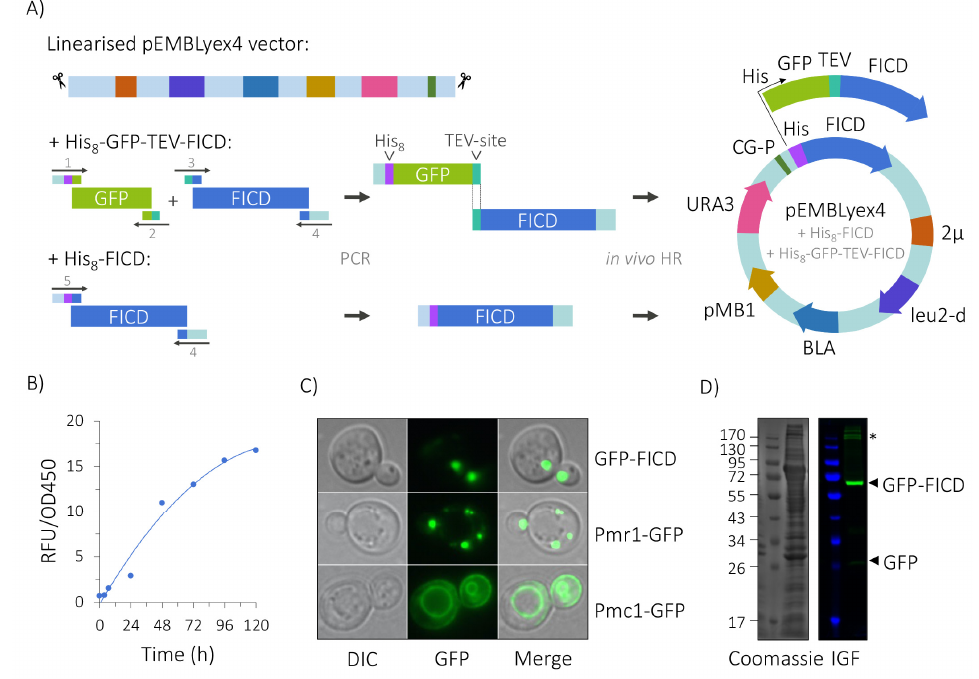
Figure 3. Generation and expression of FICD constructs. ( A ) FICD was tagged with His 8 -GFP-TEV (where TEV denotes a tobacco etch virus protease cleavage site) or His 8 alone and ligated into linearised pEMBLyex4 vector by in vivo homologous recombination (HR) in S. cerevisiae . The His 8 -GFP- TEV, TEV-FICD and His 8 -FICD DNA fragments were constructed by PCR using appropriate cDNA templates and primers containing overlapping sequences (see Table S1 for primer details). CG-P, CYC-GAL promoter; leu2-d , a poorly expressing allele of the β -isopropylmalate dehydrogenase gene; URA3 , selective marker gene encoding the orotidine-5 ′ -phosphate decarboxylase enzyme; BLA , β -lactamase gene; 2 μ , 2- μ m origin of replication; pMB1, bacterial origin of replication. ( B ) Time dependent accumulation of His 8 -GFP-TEV-FICD (GFP-FICD) after galactose induction at 15 °C, with whole-cell fluorescence measured in relative fluorescence units (RFU) in 1 OD 450 unit of cells. ( C ) Cellular localisation of GFP-FICD, Pmr1-GFP (Calcium-transporting ATPase 1 (Golgi)) and Pmc1-GFP (Calcium-transporting ATPase 2 (vacuole)), imaged by fluorescence and phase contrast microscopy. (1000×). ( D ) SDS-PAGE analysis of GFP-FICD-containing membranes (corresponding to 200 RFU) by Coomassie staining (left) and in-gel fluorescence (IGF, right). High molecular weight species are marked with an asterisk (*)). 2. Results 2.1. Recombinant GFP-FICD Is Expressed to a High Density in S. cerevisiae To generate the expression vectors encoding human His 8 -GFP-TEV-FICD (GFP- FICD), including a TEV protease cleavage site, or His 8 -FICD (His-FICD), we utilised the ability of S. cerevisiae to recombine linear DNA fragments by homologous recombination (Figure 3A, Table S1). We chose to perform FICD expression at 15 °C, as previous experi- ments have shown that although S. cerevisiae grows optimally at 30 °C, membrane protein folding and maturation is often compromised at this temperature [32,34]. To determine the appropriate induction time, the total cell GFP fluorescence was measured at 24 h in- tervals (Figure 3B). In total, 120 h after induction, fluorescence accumulation slowed down significantly, and the cells were harvested. GFP-FICD was expressed to a concentration of approximately 180 pmol/mg membrane protein, corresponding to approximately 1.5% of total membrane protein content. The optimal expression conditions obtained from the small-scale experiments were subsequently applied for large-scale production of the His- FICD construct in 15-litre bioreactors (see below).